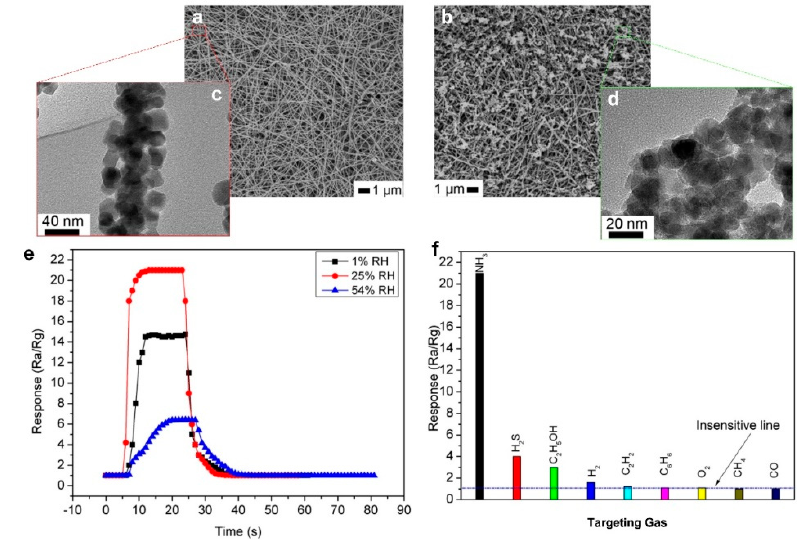
Figure 7. SEM images of ( a ) pure In 2 O 3 nanofibers and ( b ) 16at% SnO 2 nanoparticles/In 2 O 3 nanofibers. The TEM images of ( c ) SnO 2 nanoparticles and ( d ) In 2 O 3 nanofibers. ( e ) Response-time curves of 16at% SnO 2 /In 2 O 3 nanofiber sensors to ( e ) 1 ppm NH 3 at 1%, 25%, and 54% RH and ( f ) 1 ppm of different gases at room temperature [56].